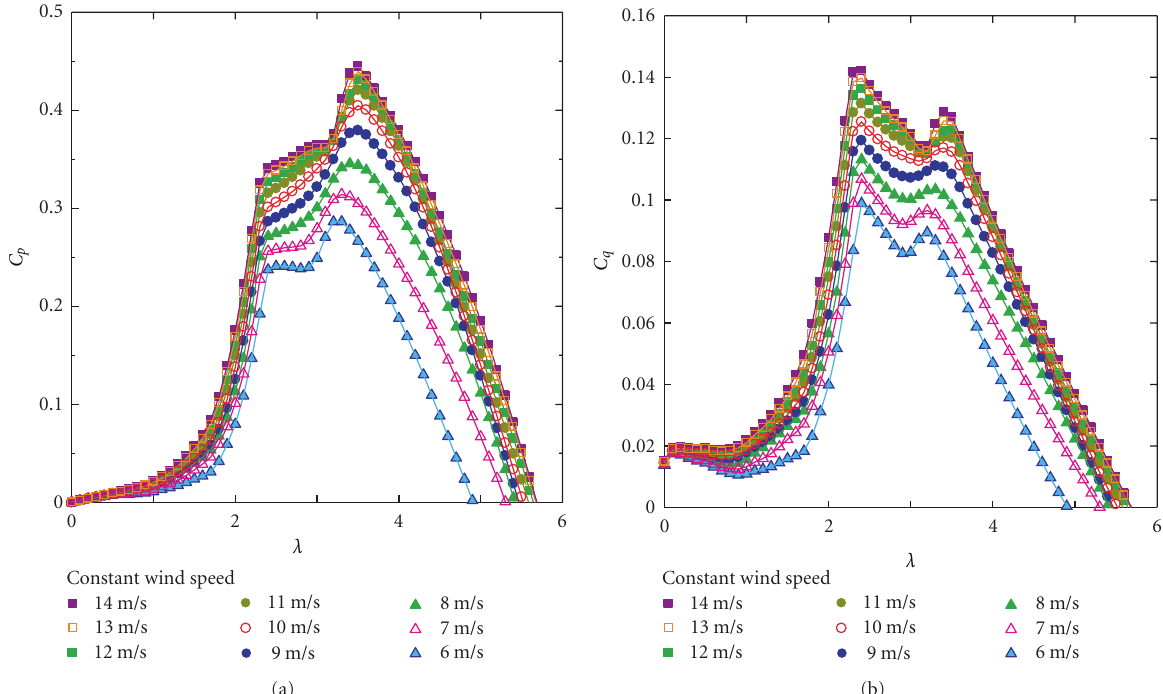
Figure 14: Simulated power ( C p ) and torque ( C q ) coe ffi cients for a theoretical VAWT with NACA 0018 airfoil.